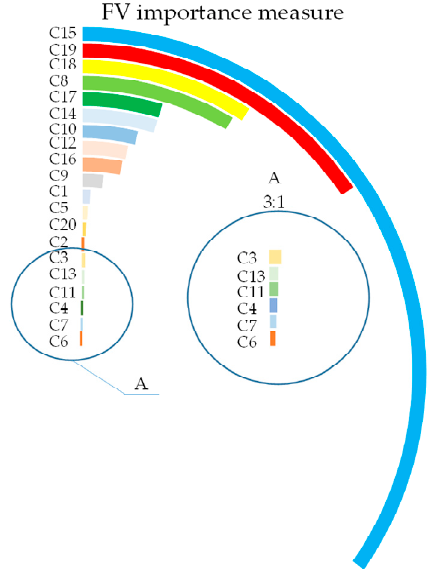
Figure 9. Radial bar chart of FVIM.